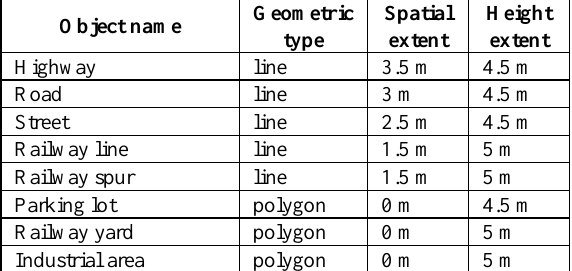
Table 2. Additional used types of objects from